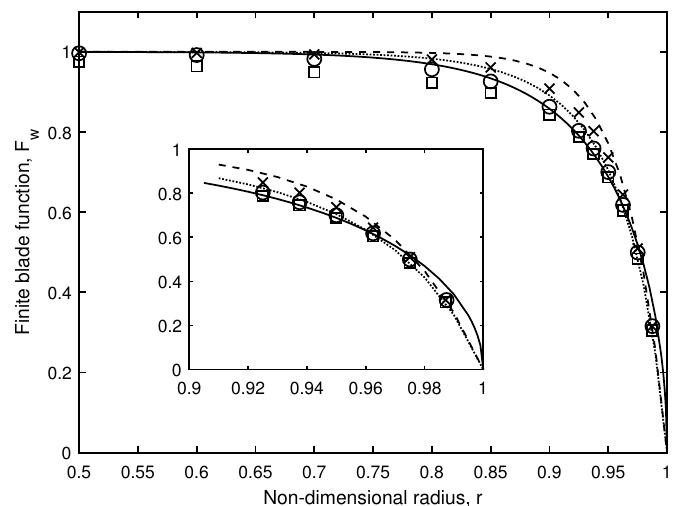
Figure 2. Circumferential finite blade function, F u for conditions in Table 1, p = 0.1. Solid line shows F P , dashed line is F u = F w from the Kawada-Hardin Equation (6), and dotted line, F u = F w from the modified pitch Equation (20). shows Biot-Savart calculation with Equation (12); , Biot-Savart ⃝ × calculation with Equation (17) and upper limit 1000 π ; □ Biot-Savart calculation with Equation (17) but upper limit = 2 π .